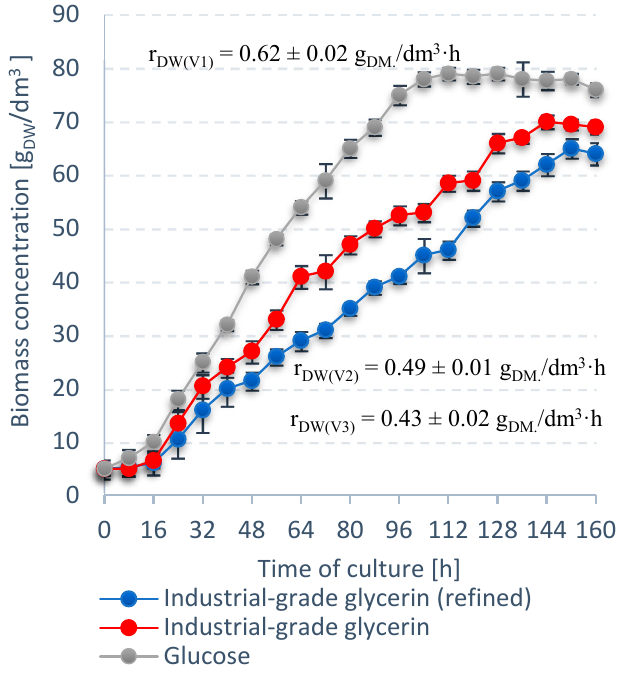
Figure 3. Trends in biomass concentration for S. limacinum E20 biomass for different carbon sources.